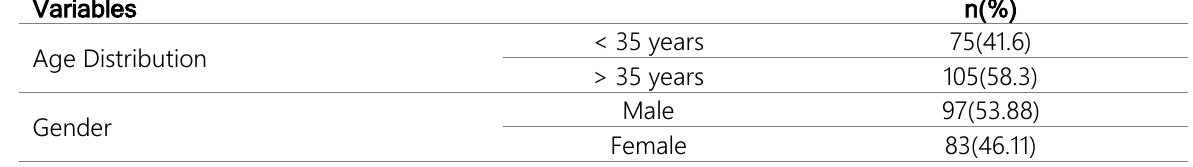
Table 1: Demographic characteristics of the study population